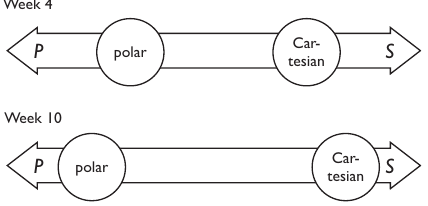
FIG. 7. A comparison of plasticity of polar and Cartesian for Wes in weeks 4 and 10. Cartesian has become more solid as his Cartesian choices become tailored to the problem at hand, while his polar resource seems more